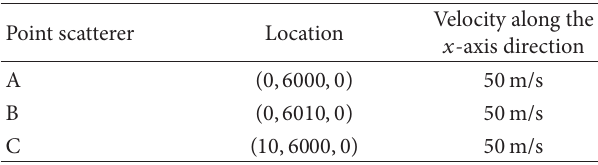
Table 3: The velocity and location of the three point